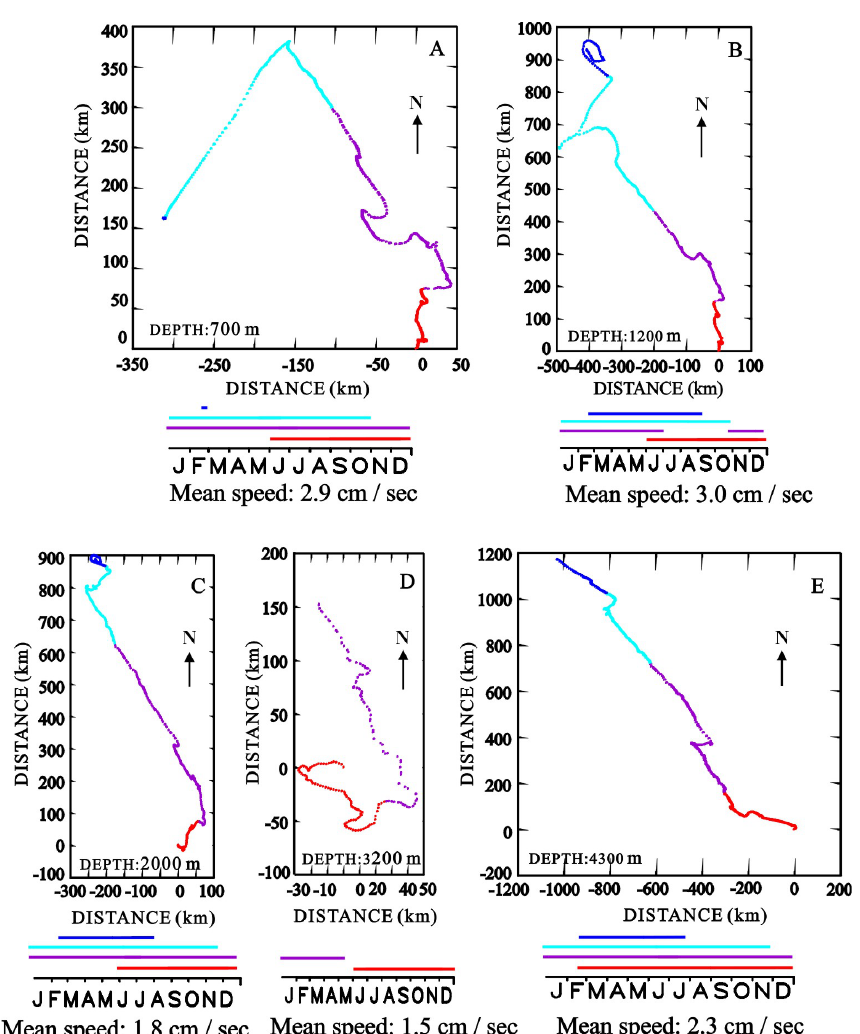
Fig. 3. Progressive vector diagrams based on unfiltered current meter data at the various depths of measurements on the mooring at NESTOR site. Corresponding colored lines below indicate the duration and time coverage of the current record for each specific year they refer to. (A) 700m, (B) 1200m, (C) 2000m, (D) 3200m, (E)